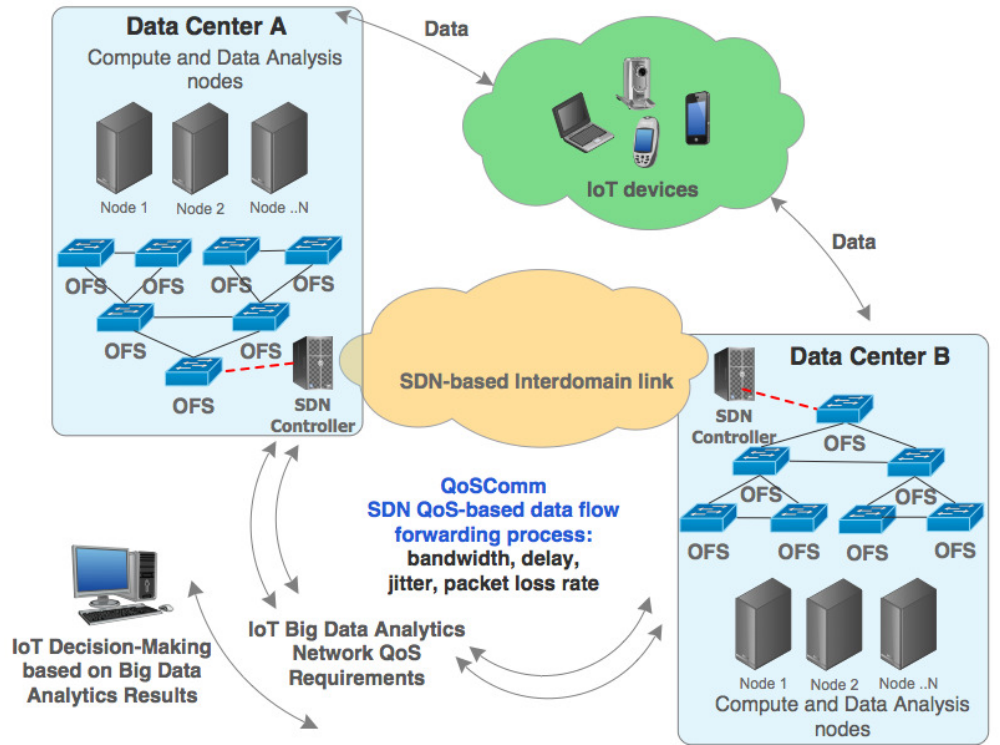
Figure 1. IoT Big Data Analytics and QoSComm general